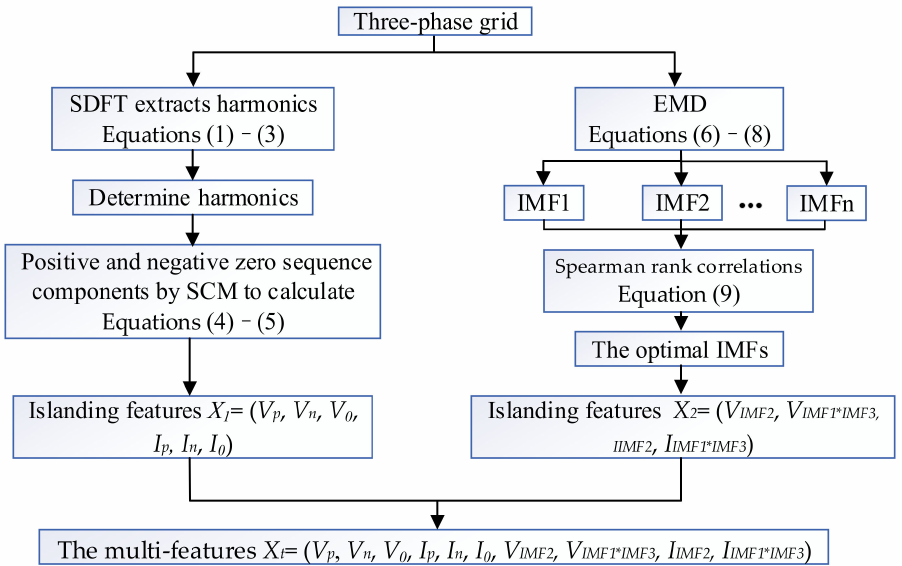
Figure 10. The schematic diagram of feature extraction.